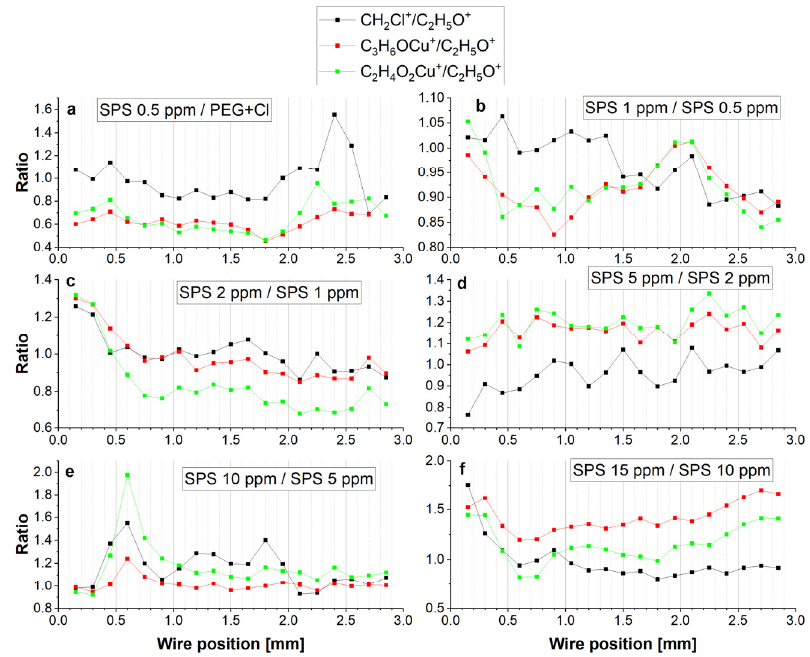
Figure 5. ( a – f ). The ratio of intensities of CH 2 Cl/C 2 H 5 O + , C 3 H 6 OCu + /C 2 H 5 O + , and C 2 H 4 O 2 Cu + /C 2 H 5 O + , obtained by dividing the ratios of the latter fragments of the adjacent sample to the ratio of the former sample. For example, the assignment SPS0.5ppm/PEG/Cl corresponds to the ratio CH 2 Cl + /C 2 H 5 O + for SPS 0.5 ppm (adjacent sample) divided by the ratio CH 2 Cl + /C 2 H 5 O + for PEG/Cl (the former